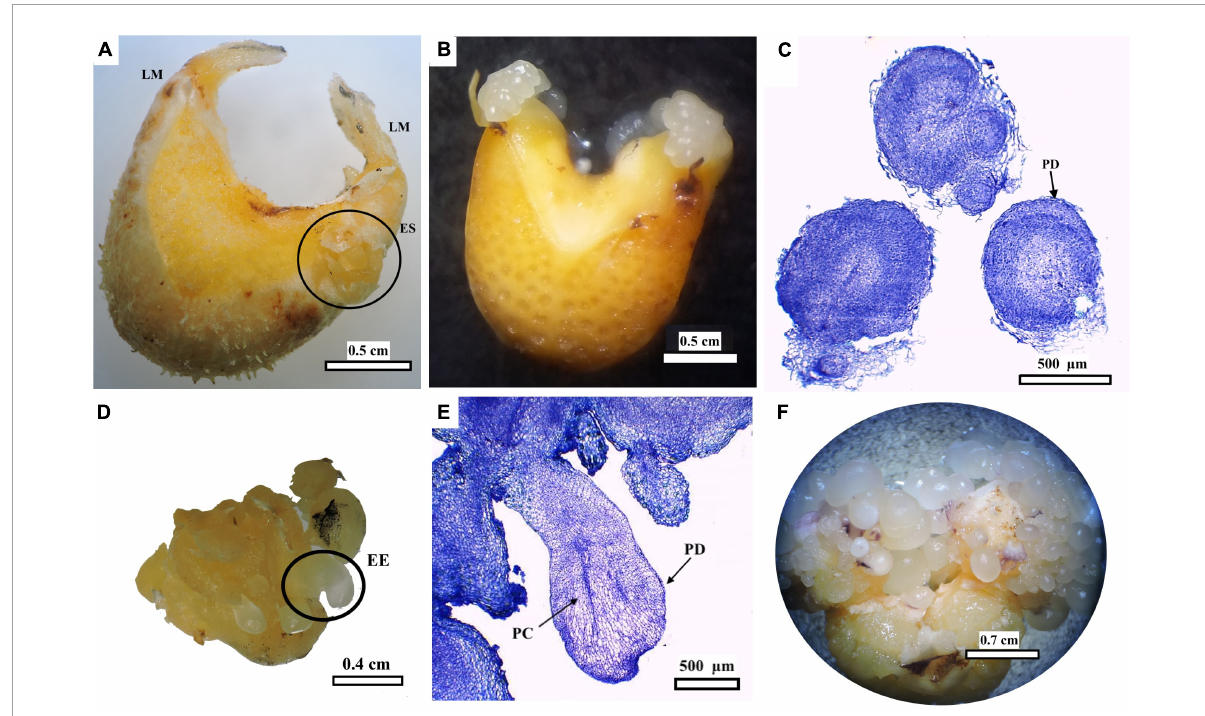
FIGURE7 Induction and development of peach palm embryogenic cultures. Swollen TCL showing location of leaf sheath margins (LM) and of initial embryogenic structures (ES) (A) . ES further increased their size causing detachment of LM (B) . Histological analysis of globular embryos with protoderm (PD) (C) . Elongated embryos (EE) (D) Histological sections of EE showing procambium (PC) and PD (E) Multiplication of somatic embryos forming embryogenic clusters (F) . Black bars scale equivalent to 0.5 cm (A,B) , 500 µ m (C) , 0.4 cm (D) , 500 µ m (E), and 0.7 cm (F)